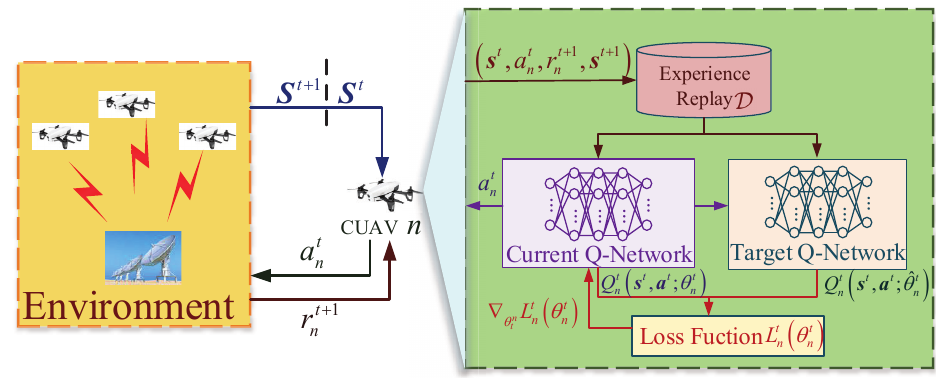
Figure 5. IL-DQN-UCB-H of CUAV n for joint sensing and